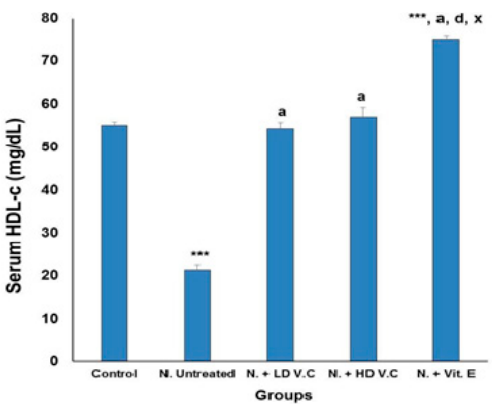
Figure 3. Effect of V. calvoana extract on serum high density lipoprotein cholesterol in paracetamol treated rats. Values are presented as mean ± SEM, n = 5. *** p <0.001 vs. control, a = p <0.001 vs N. untreated, d = p <0.001 vs N. + LD V.C., x = p < 0.001 vs N. + HD V.C.Where N = hepatotoxic.